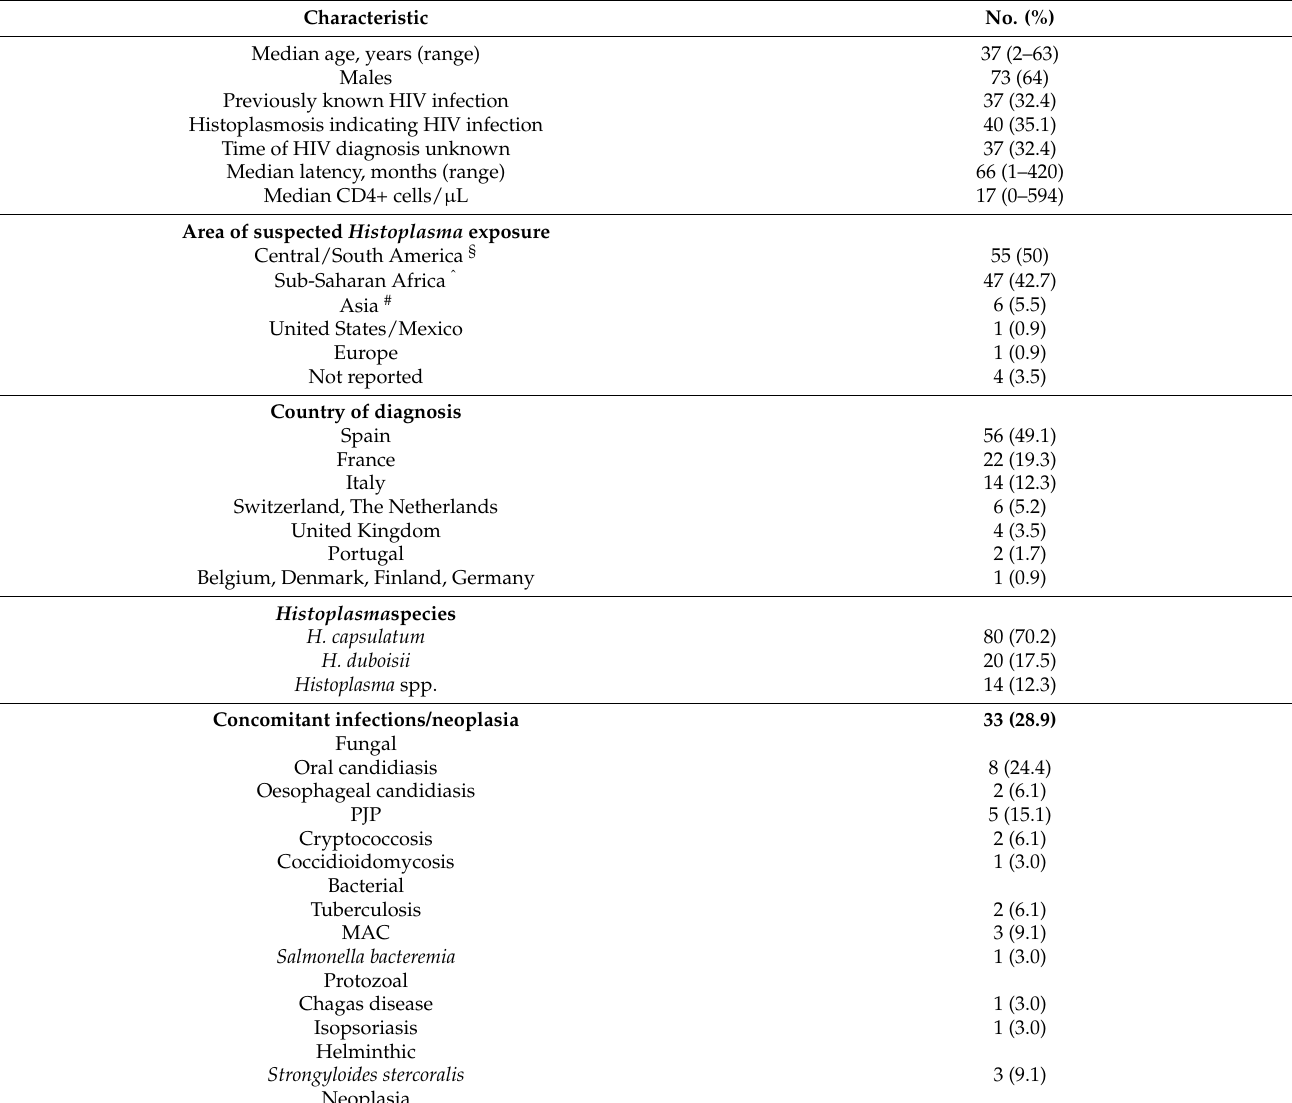
Table 2. Characteristics of 114 patients * living with HIV/AIDS diagnosed as having histoplasmosis in Europe.